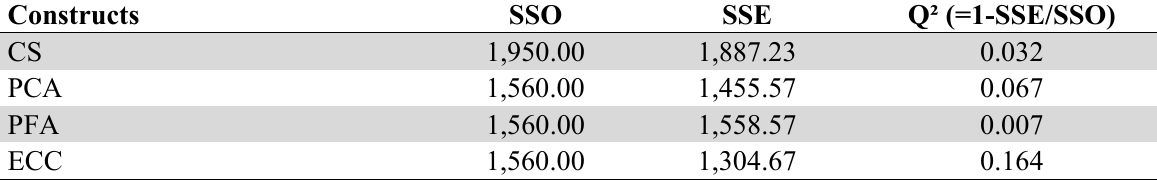
Predictive Capability of the Model (Construct Cross-Validated Redundancy)